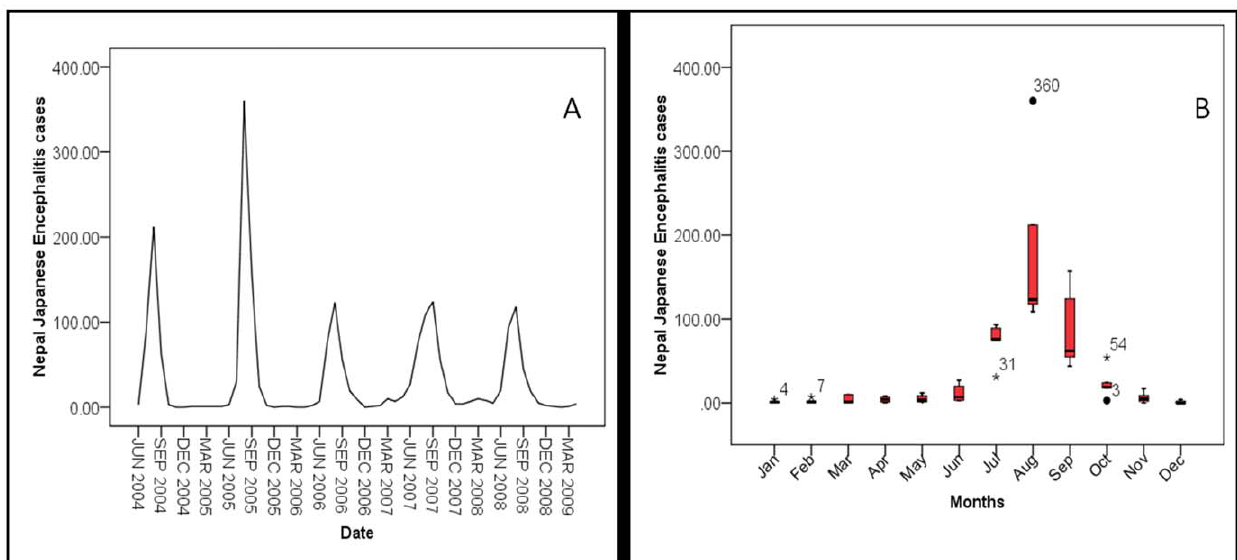
Figure 1. Time Series graph (A) of laboratory confirmed Japanese Encephalitis (JE) cases and a box plot (B) of seasonal transmission of confirmed JE cases from June 2004 to April of 2009. The dark line in the middle of the boxes is the median value; the bottom and top of the boxes indicates the 25th and 75th percentile respectively; whiskers represents 1.5 times the height of the box; and dots with numbers represent value of outlier cases and asterisks with number represent extreme values outlier cases (i.e. more than three times the height of the boxes).